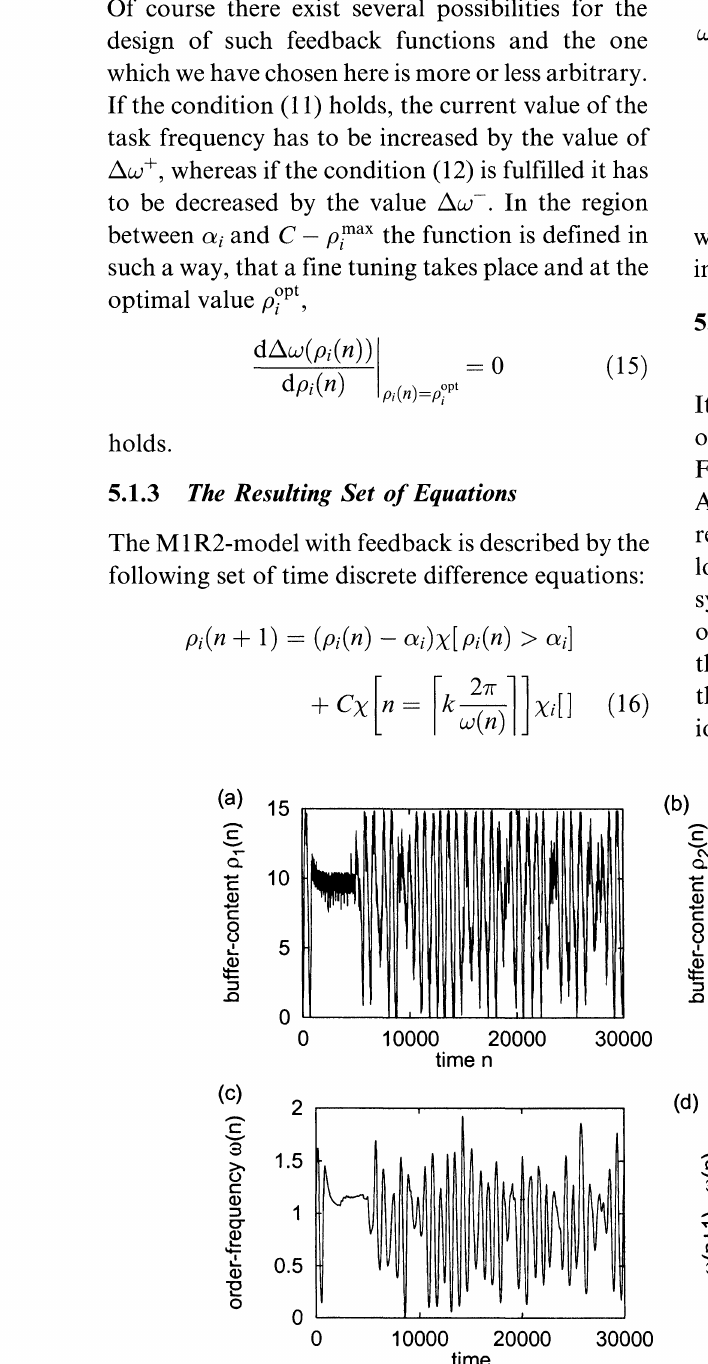
FIGURE 4 Behaviour of the M1R2-model with feedback. Parameter values: C= 1, p(0)=0, p2(0)=0,